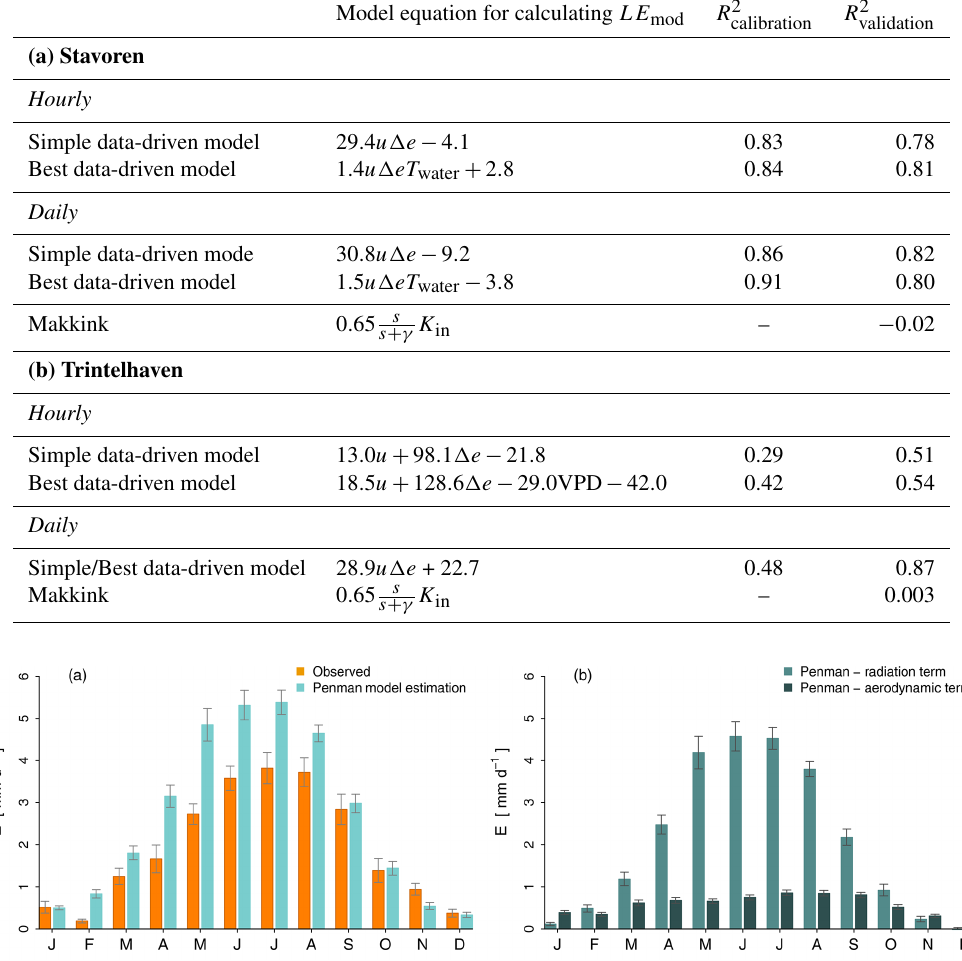
Table 2. Evaluation of the developed “simple” and “best” data-driven models based on routinely measured observations (see Sect. 3.4) during the summer of 2019 (calibration) and 2020 (validation) to estimate open water evaporation in Stavoren (Table 2a) and Trintelhaven (Table 2b) at hourly and daily timescales. The models presented here are independent of the results found based on our own observations. The results of estimated evaporation using Makkink’s model are provided as a reference. Model performance is indicated by the values of the coefficient of determination ( R 2 ).